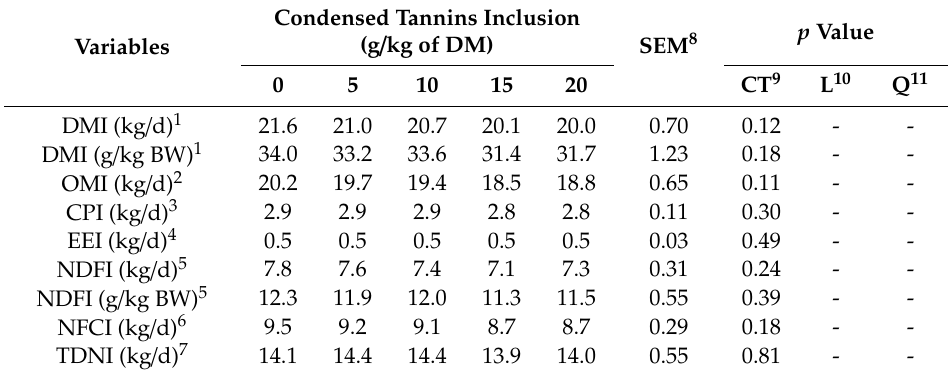
Table 3. Intake of dry matter and nutrients of Holstein cows fed diets with five levels of condensed tannins from Acacia